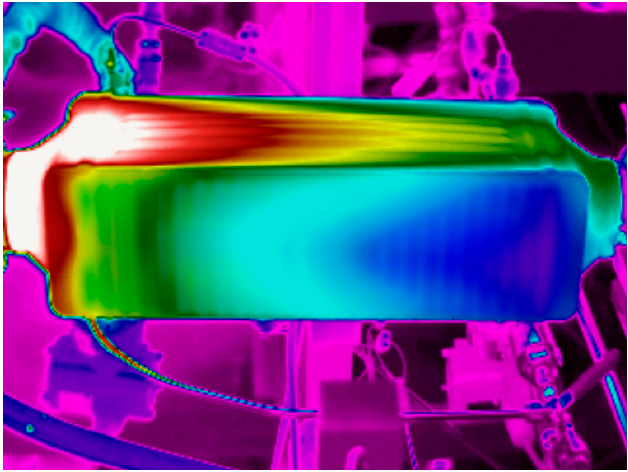
Figure 10. Thermography of the boiler with the operating conditions described in Table 4.